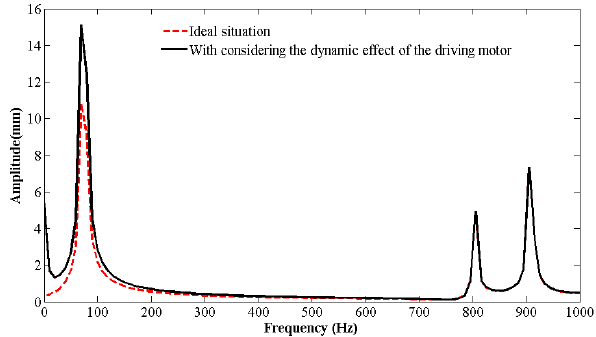
Figure 3. Frequency responses of the MDFMS under velocity mo- tions.